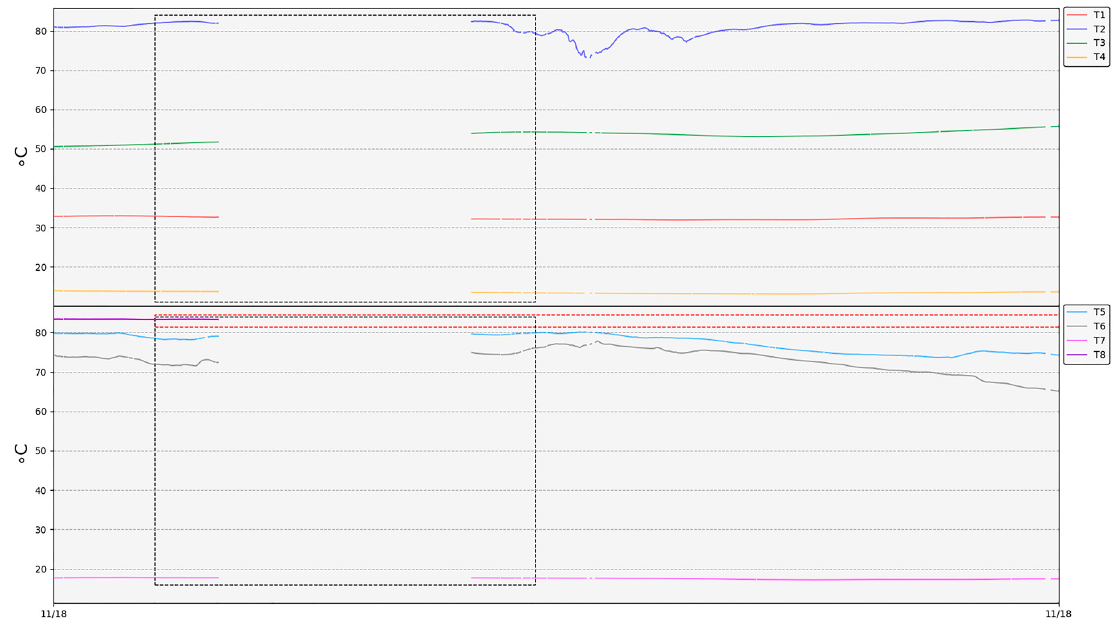
Figure 14. Detail of the temperature record when interruptions in the network operation (grey dashed rectangle) take place due to adverse weather conditions.